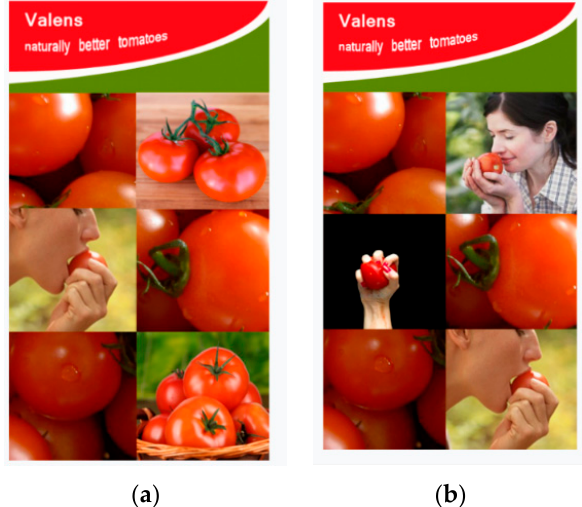
Figure 3. Experimental stimuli used in Study 2: ( a ) Single-sense ad; ( b ) Multiple-sense ad.